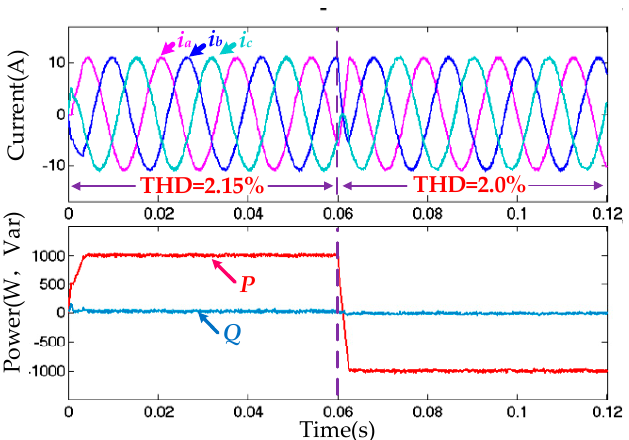
Figure 9. Simulation results of switching between inverter and rectifier mode with proposed MPDPC for fault-tolerant BVSC.